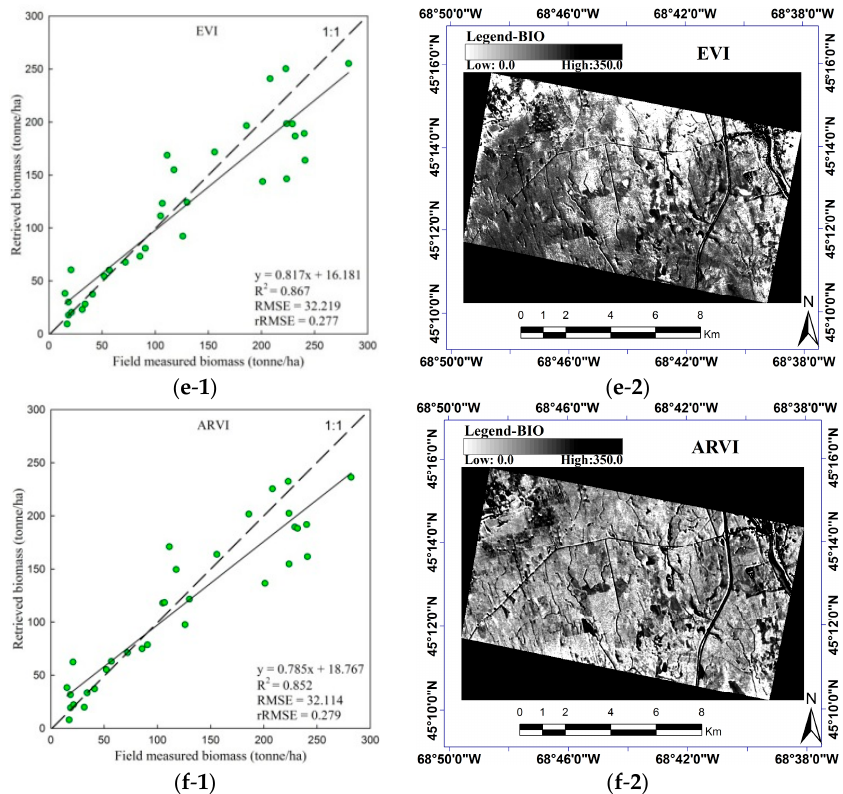
Figure 5. The performance of biomass inversion using six VIs, combining all angles with all bands in Table 8. ( a - 1 ) a scatter diagram comparing the measured biomass with the inversion biomass using SRI, and ( a - 2 ) the inversion biomass thematic map using SRI; ( b - 1 , b - 2 ) are for NDVI; ( c - 1 , c - 2 ) are for PVI; ( d - 1 , d - 2 ) are for SAVI; ( e - 1 , e - 2 ) are for EVI; (f- 1 , f - 2 ) are for ARVI.